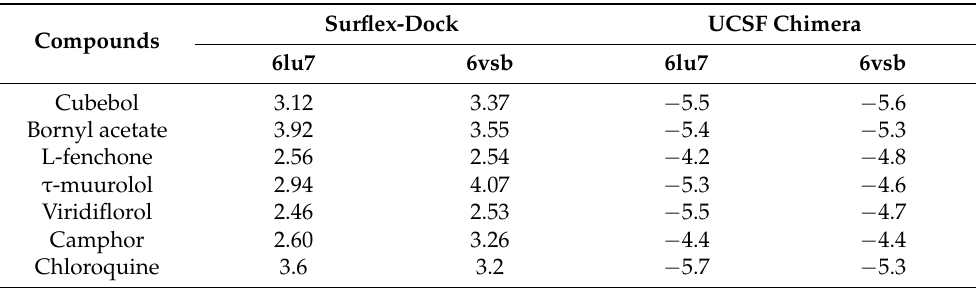
Table 5. Molecular docking energy affinities of both receptors (pdb:6lu7 and pdb:6vsb) using Surflex- Dock and UCSF Chimera software.